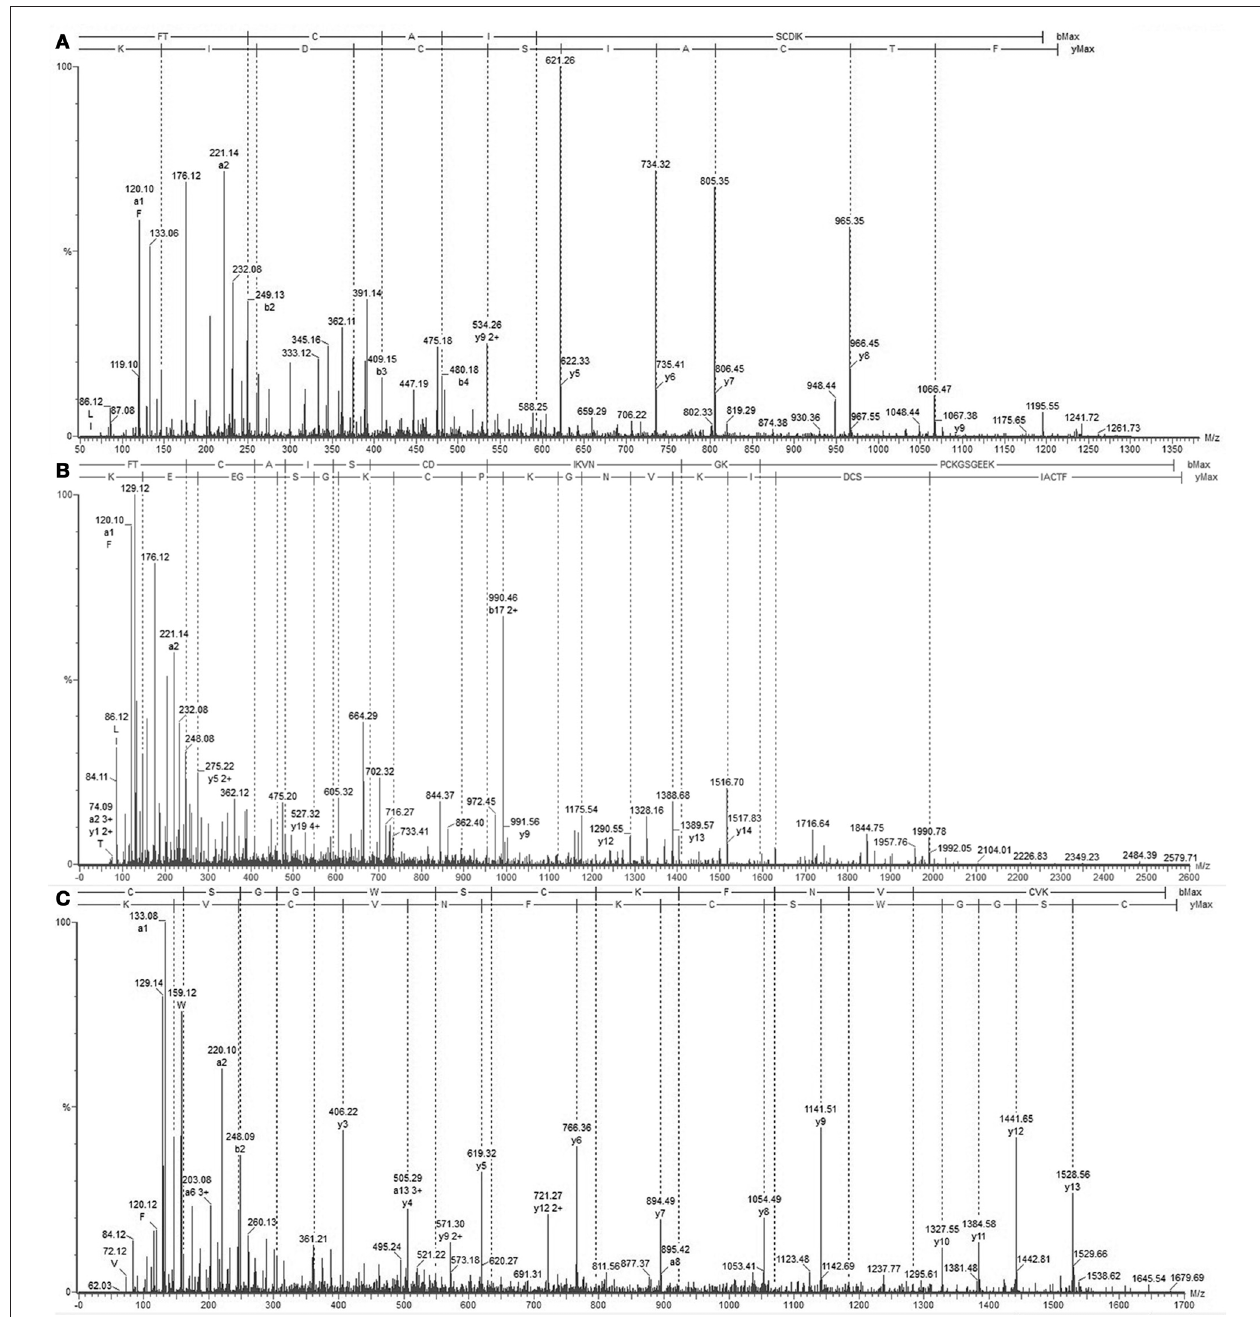
FIGURE 4 | Mass spectrometry analysis of Juruin peptides. (A) Collision-induced dissociation spectrum from mass/charge ( m / z ) 1211.3 generated by trypsin digestion after analysis by LC/MS, showing the dominant fragment KIDCS with a m/z of 621.26, which corresponds to an N-terminal segment. (B) Collision-induced dissociation spectrum from m / z 2579.8, showing the b and y ion series that corresponds to